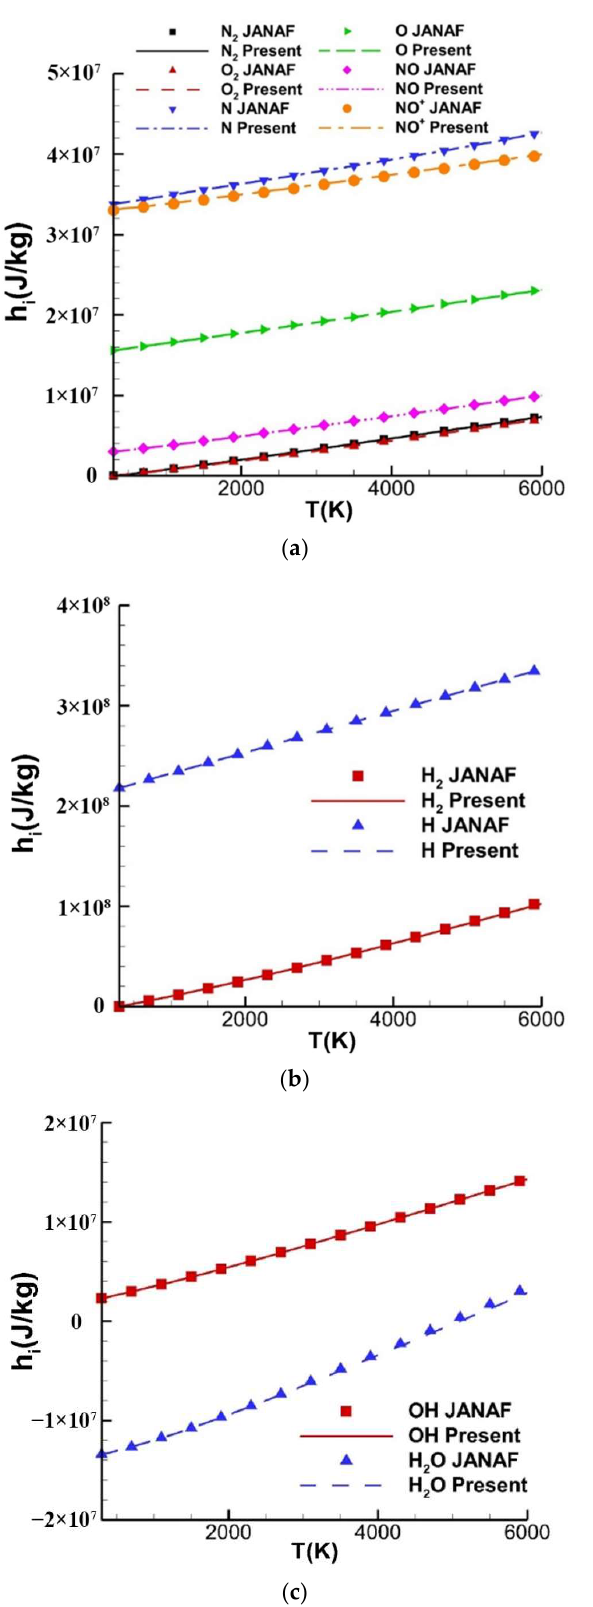
Figure 7. Comparison of specific enthalpy of species. ( a ) Air species. ( b ) Species H 2 and H. ( c ) Species OH and H 2